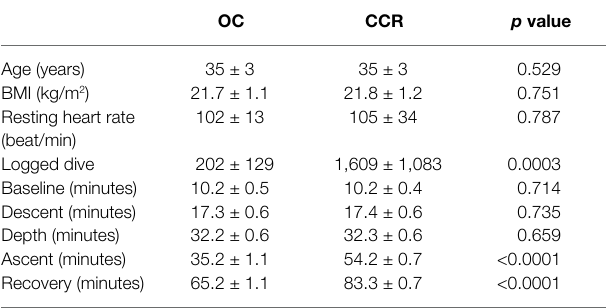
TABLE 1 | Anthropometric data and time of RR interval sampling in the two diving